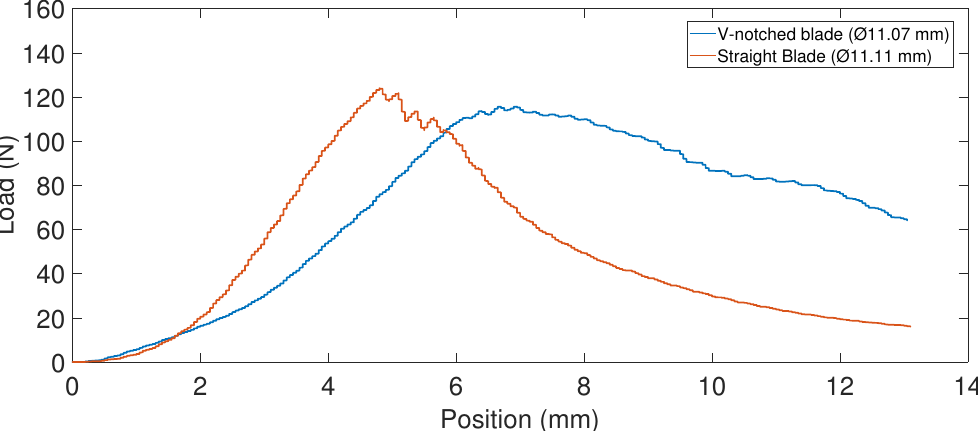
Figure 11. Difference in steepness of the slope between the V-notched and straight